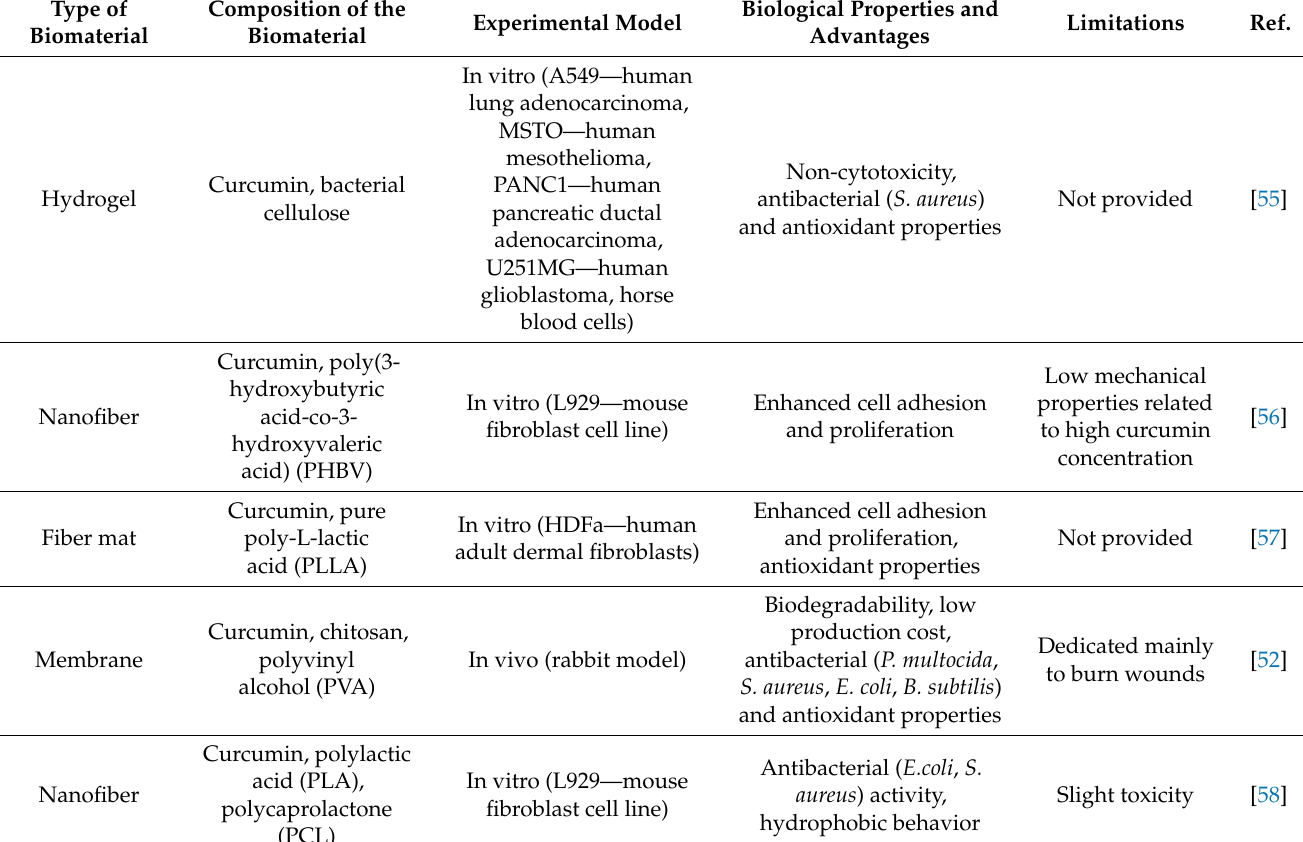
Table 1. Curcumin-loaded biomaterials for wound healing